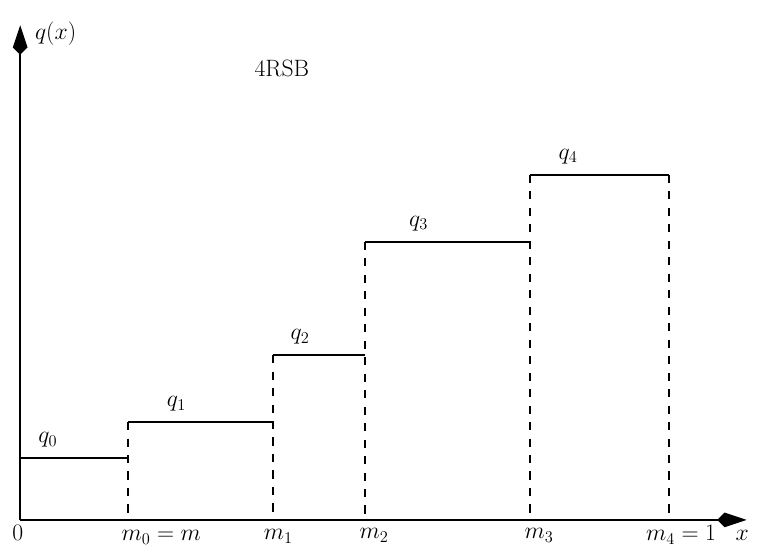
Figure 5: An example of the parametrization of the matrix Q should keep in mind that we use the convention m